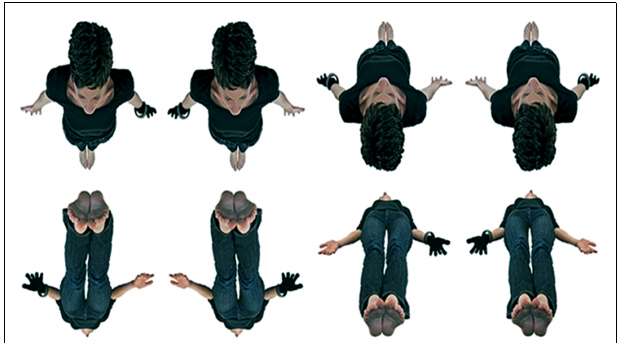
FIGURE 1 | Stimuli from the new Human-own-body-transformation task (HOBT) where avatars from both ‘Above’ (top row) and ‘Below’ (bottom row) perspectives were used . Note, while all avatars require the transformation of plane, the two avatars in the upper row/ left hand side, and lower row right-hand side also require a rotation of body as well. Therefore the stimuli are distinguishable along two a-priori dimensions, one of plane and one of